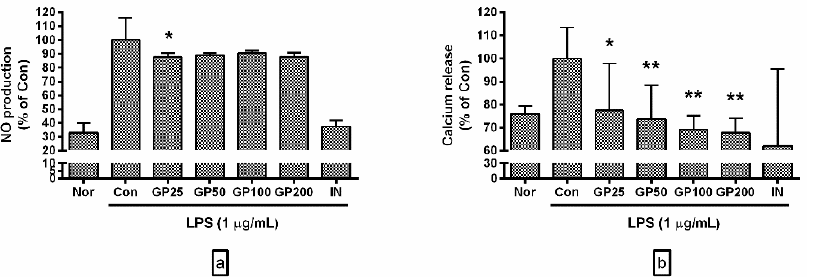
Figure 1. Effects of a combination extract of Gardeniae Fructus and Perillae Folium (GP) on levels of NO ( a ) and Ca 2+ ( b ). Values are mean ± SD of the three independent experiments. Nor, normal group (media only); Con, control group (LPS alone); IN, indomethacin (0.5 µM). GP25, GP50, GP100, and GP200 indicate 25, 50, 100, and 200 µg/mL of GP, respectively. * p < 0.05 vs. Con; ** p < 0.01 vs. Con.